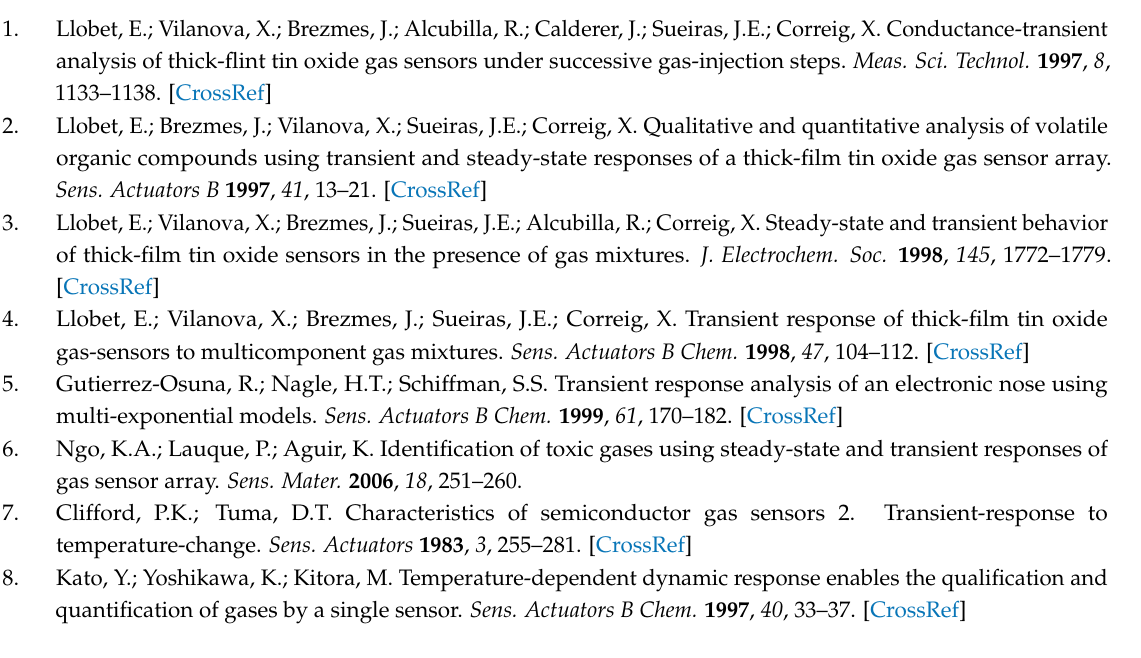
s1. Figure S1: Sensor substrate used, Figure S2: SEM image of the WO 3 nanoneedles conforming the active layer of the sensor, Figure S3: Typical EDX spectrum of a sensing layer, Figure S4: XRD spectrum for the WO 3 nanoneedles, Figure S5: Raman spectrum for WO 3